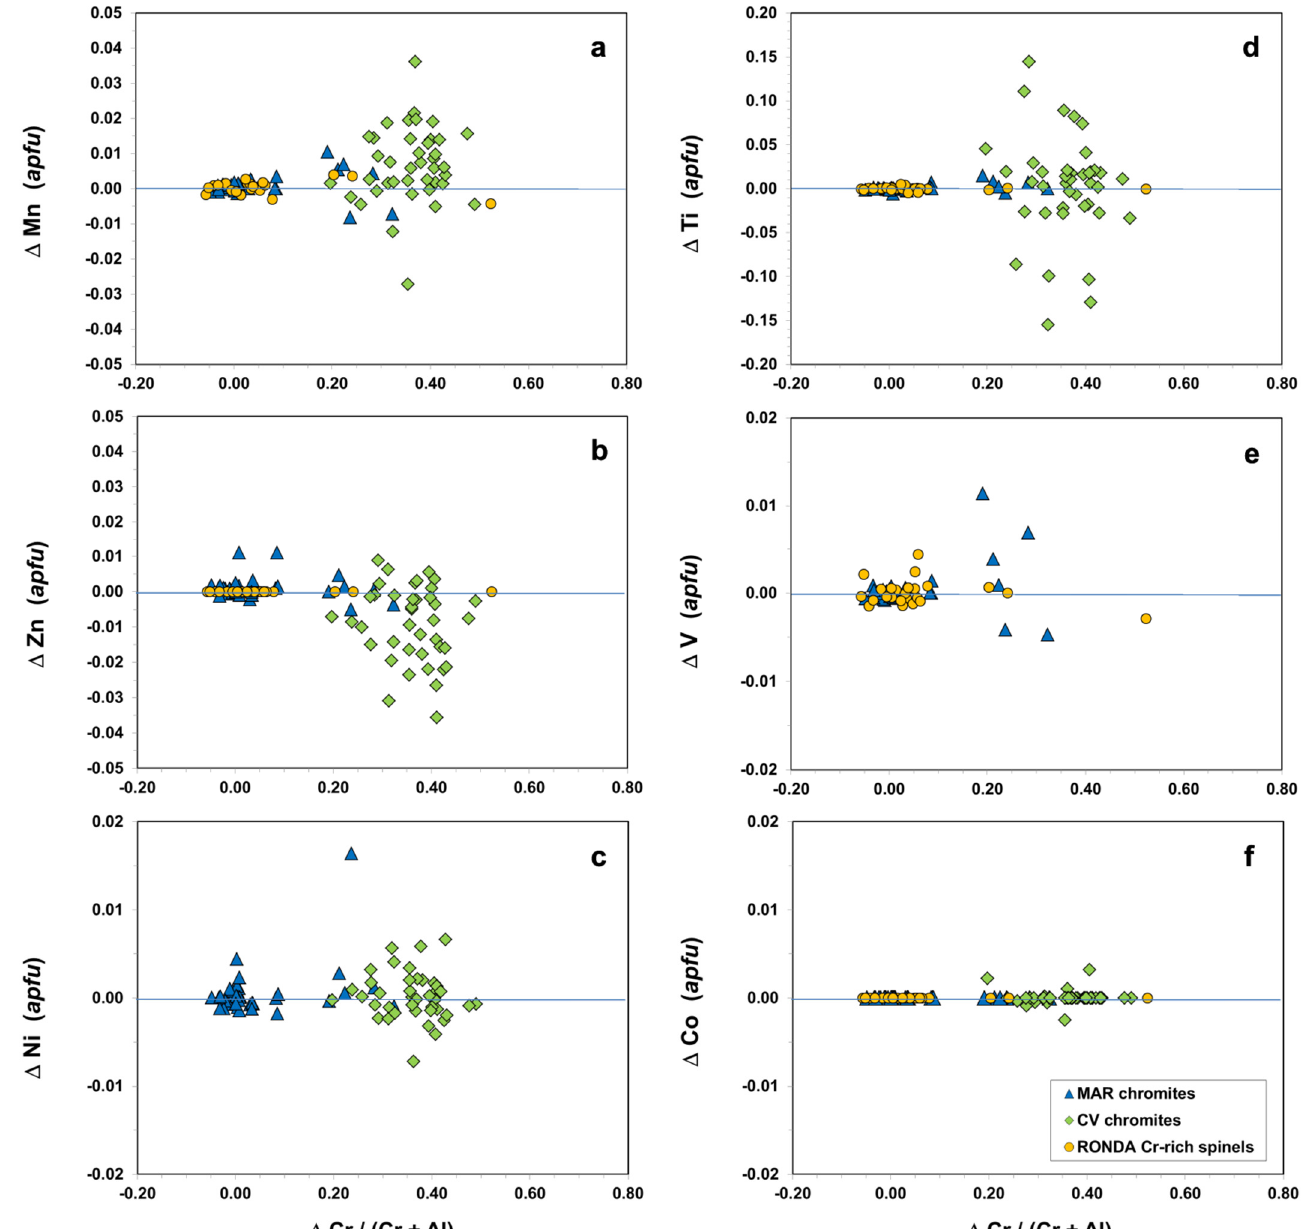
Figure 13. Variation of trace components ( a ) Ti, ( b ) V, ( c ) Mn, ( d ) Ni, ( e ) Zn and ( f ) Co with increasing Cr/(Cr + Al) ratios in the MAR magnesiochromites, CV chromites and Ronda chromian spinels. Of the six trace elements considered in this study, only V and Co might therefore be considered immobile during the chromite oxidation process, and none defines a linear variation trend that could be used to investigate possible distinctions among the three chromite populations along the oxidation process. According to the variation depicted in